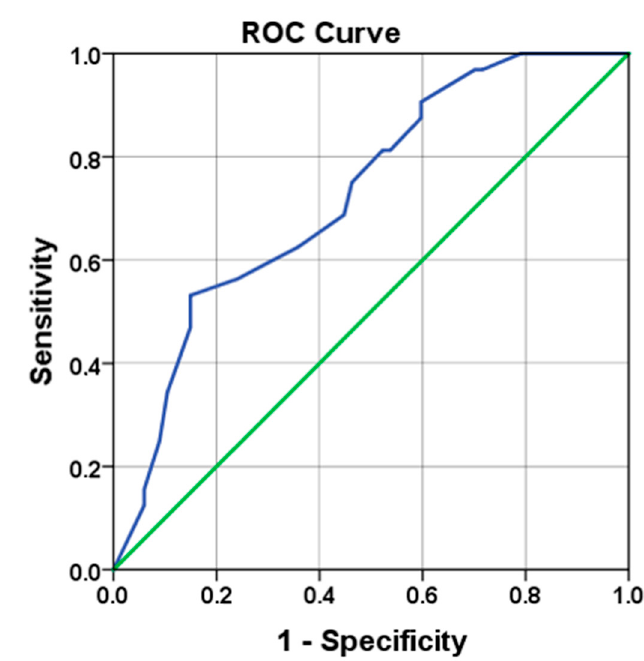
Figure 2. Receiver operating characteristic (ROC) curve indicating the value of ultrasonographic lesion size in predicting malignancy.